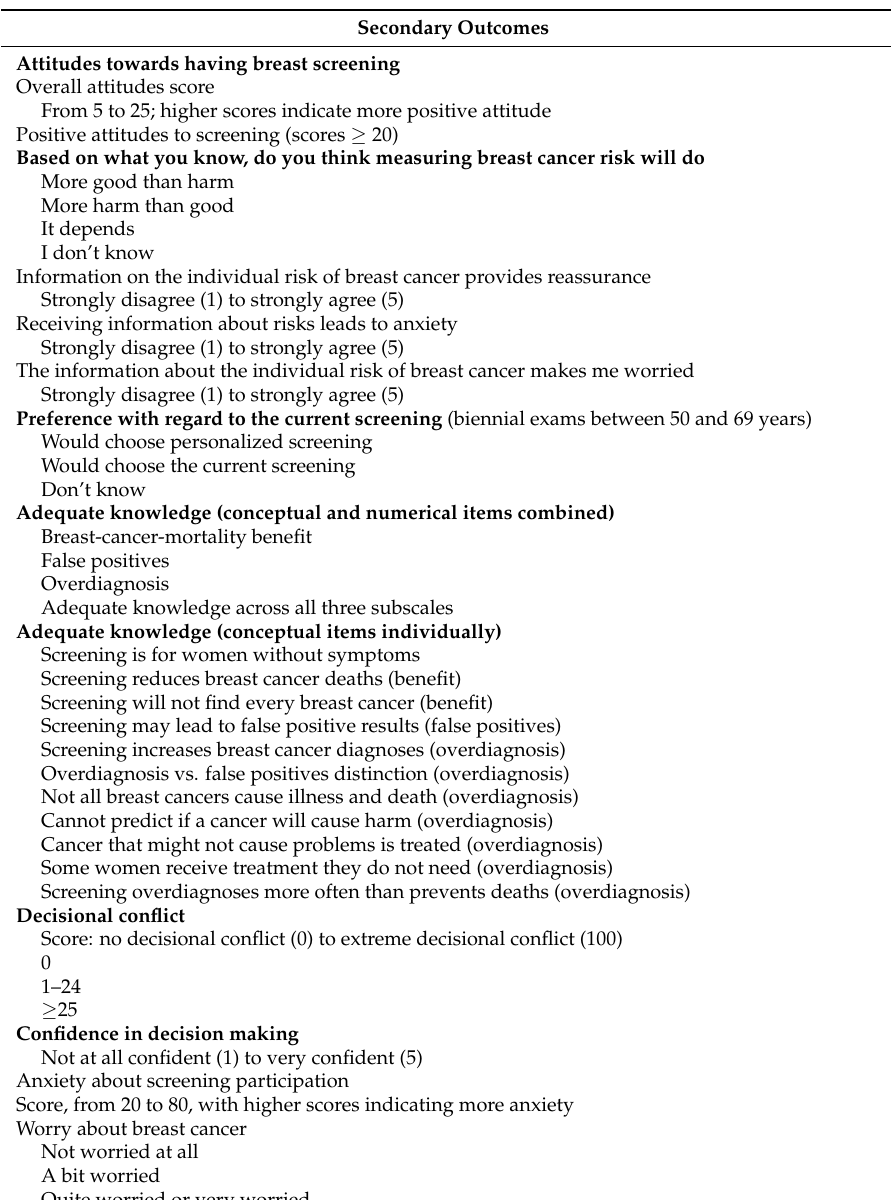
Table 4. Analysis of secondary